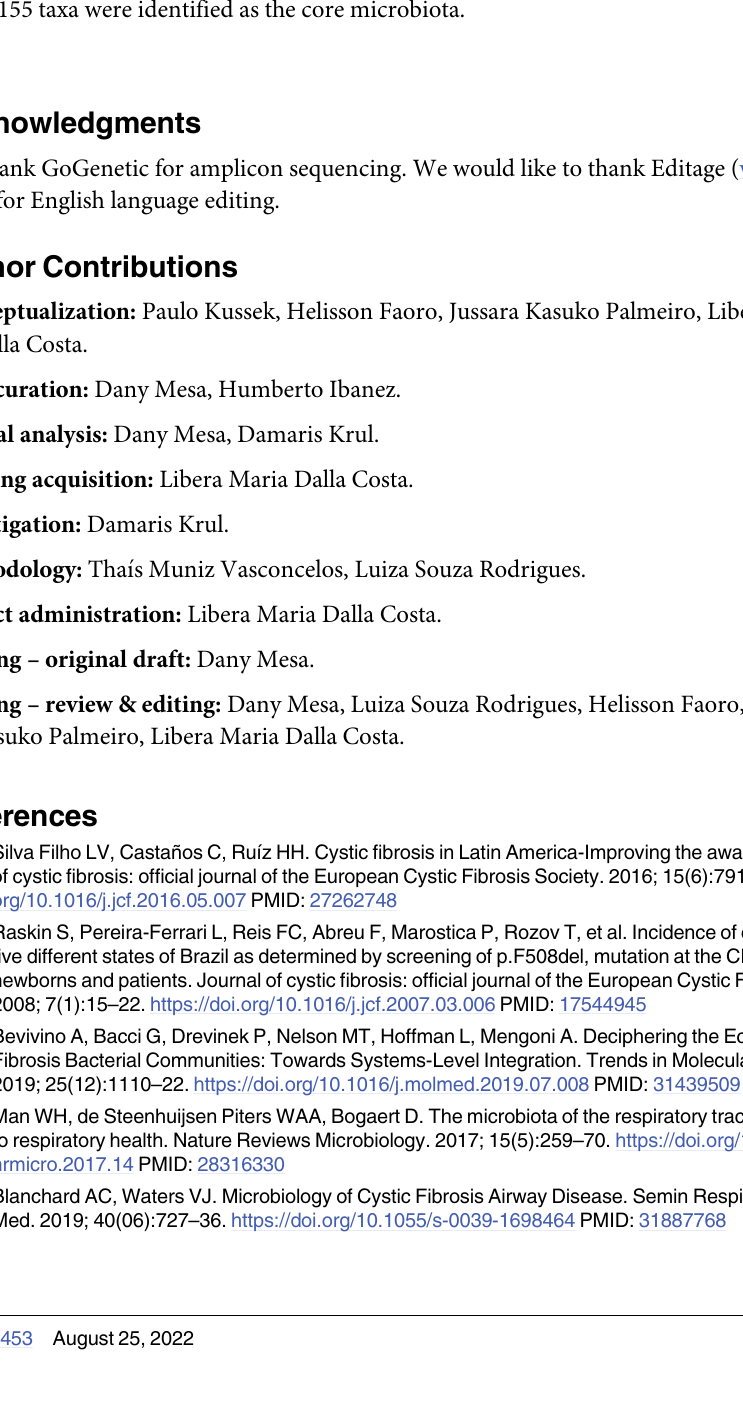
S1 Table. Clinical variables of the patients enrolled in this study. S2 Table. Complete prediction profiles. S1 Fig. Relative frequency of the most abundant genera of the bacterial community by data collection. (A) day 0; (B) day 42; and (C) day 84 of collection. S2 Fig. Venn diagram representing the core microbiota of the community by sampling time. 155 taxa were identified as the core